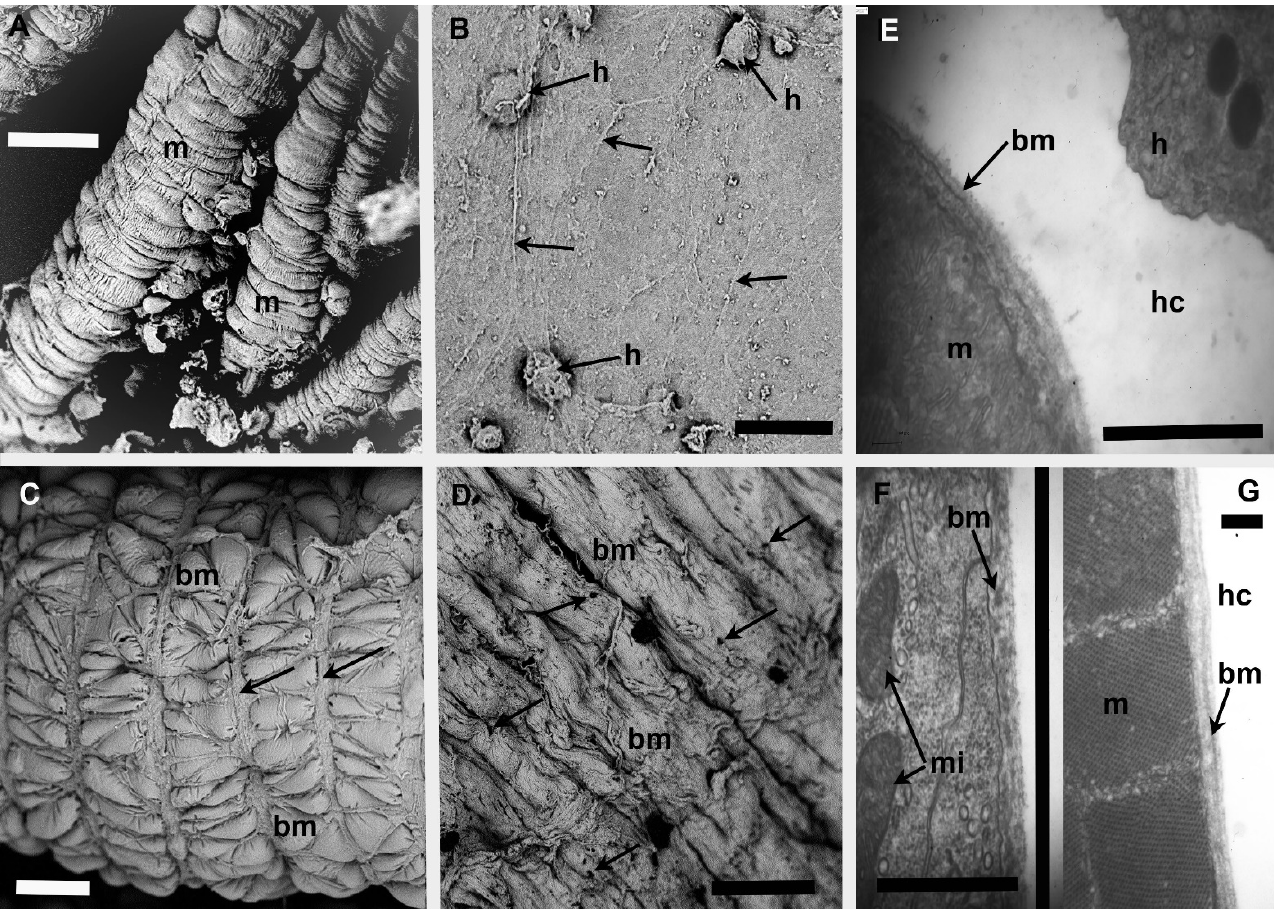
Figure 3. Tissues encased within basement membranes. ( A ) Scanning electron micrograph (SEM) of individual contracted cardiac myocytes (m). ( B ) Higher magnification SEM showing BM surrounding myocytes (which is the same as seen covering individual digestive gland tubules and abdominal muscle fibers) with attached hemocytes (h) and fine ridges (arrows). ( C ) Low magnification SEM of surface of individual tubule from digestive gland with basement membrane (bm) constricted periodically by thicker circumferentially arranged contractile cells (arrows) and thin cells running longitudinally causing the BM to form bulges. ( D ) SEM showing surface of adjacent fibers from abdominal muscle covered by a basement membrane (bm). An occasional collagen fiber and small pores (arrows) are seen on the surface. ( E ) Transmission electron micrograph (TEM) showing thin basement membrane (bm) covering a myocyte (m) and the edge of hemocyte (h) in adjacent hemocoel (hc). ( F ) TEM showing lamina densa layers of basement membrane (bm) covering the basal region of digestive gland cells with mitochondria (m) and vesicles. ( G ) TEM of basement membrane (bm) separating hemocoel (hc) and abdominal muscle cell (mc). Scale bar ( A ) 30 µm, ( B ) 15 µm, ( C ) 25 µm, ( D ) 100 µm, ( E ) 1 µm, ( F ) 0.5 µm, ( G ) 0.5 µm.